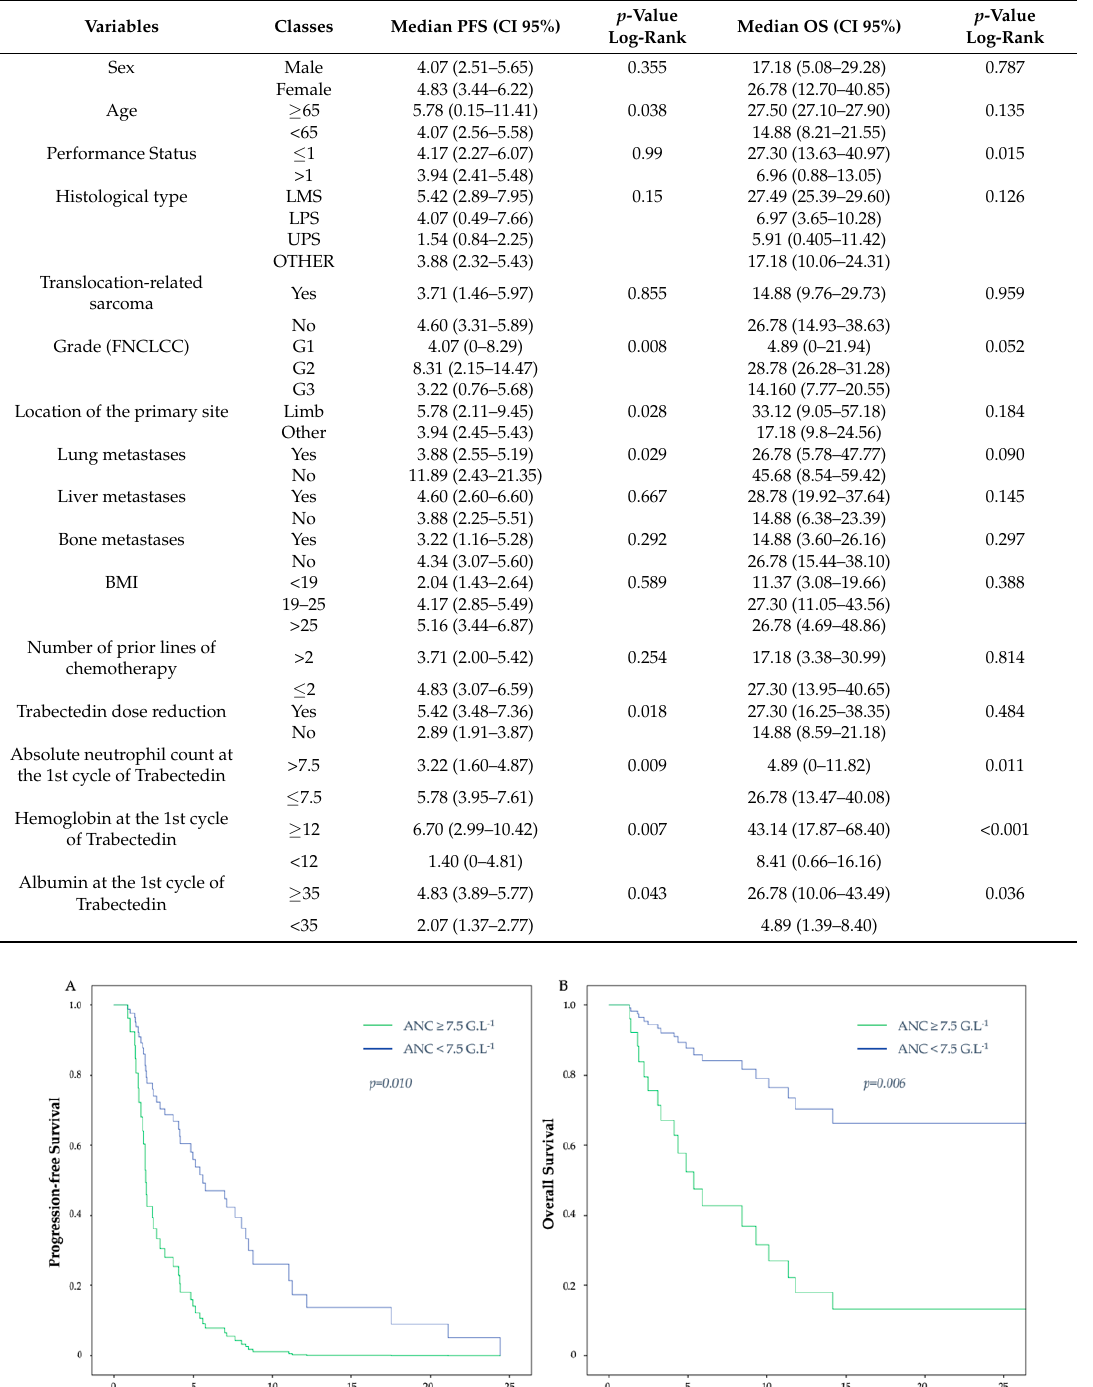
Table 2. Univariate analysis of factors associated with progression-free survival (PFS) and overall survival (OS).